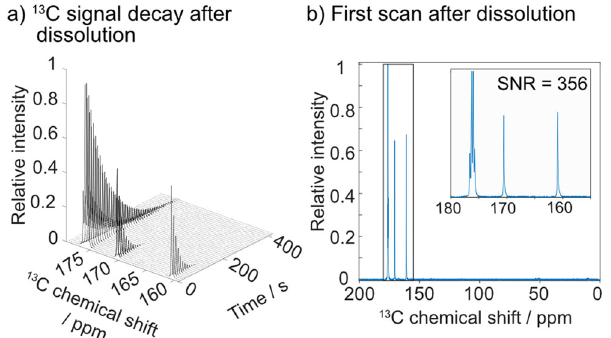
Fig. 5 NMR spectra of extracted hyperpolarized metabolites. a Full and detailed view of the fi rst 13 C spectrum. b Time series of the 13 C hyperpolarized spectra measured every 5 s with a 5° nutation angle pulse in the liquid state after hyperpolarization of a 100 μ L solution of 0.9 M [1- 13 C] glycine at, 0.9 M [1- 13 C]sodium formate, 0.9 M [1- 13 C]sodium acetate, in 90% D 2 O and 10% ethanol-d 6 in HYPOP-I and dissolution with 7 mL of D 2 O, fi ltration transfer and injection into a Bruker Fourier 80 benchtop NMR spectrometer (80 MHz 1 H